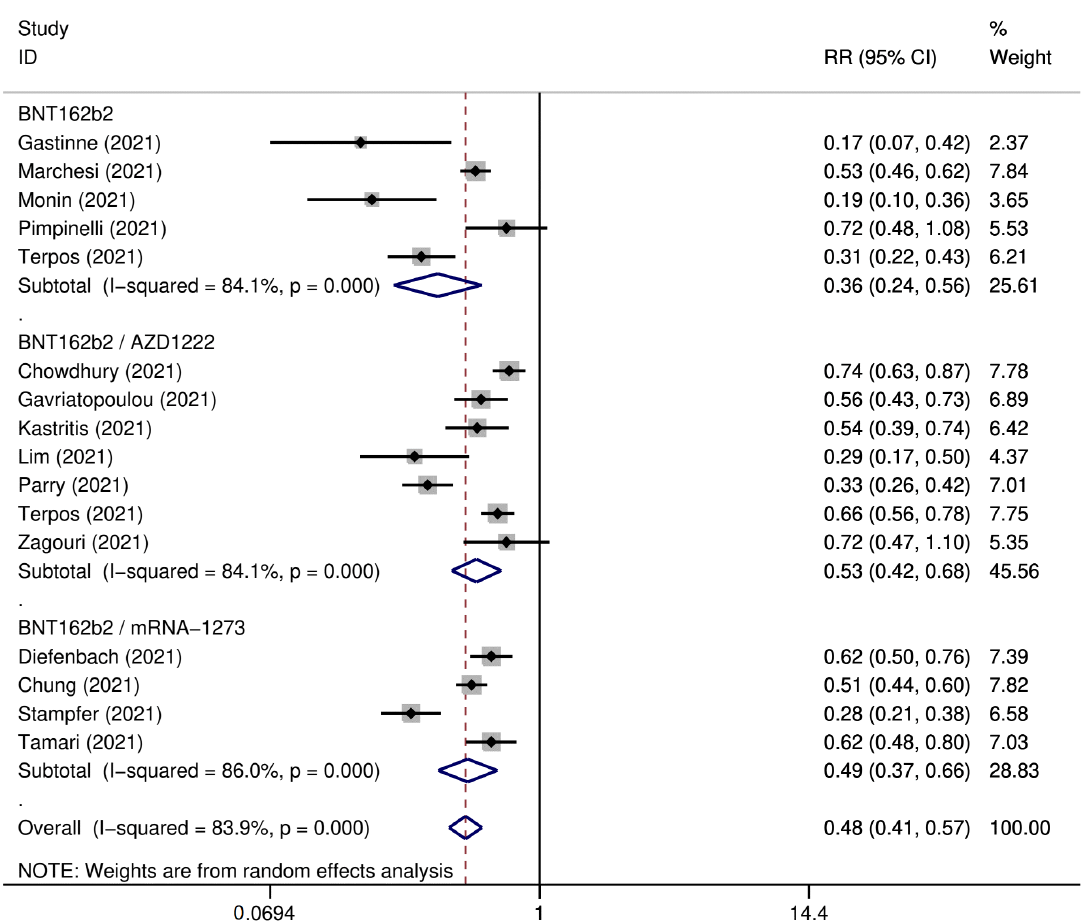
Figure 3. Pooled EffectSize (ES) for the immune seroconversion rates of patients with solid tumor after the first dose of COVID-19 vaccine [17,19,24,26,29,31,36,40,48,51,56,63,76,81].